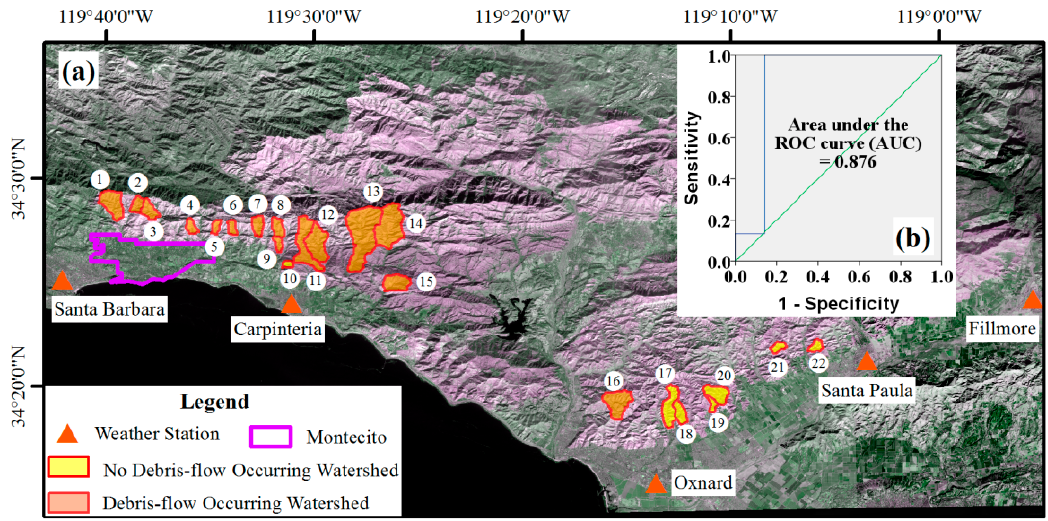
Figure 11. Model accuracy verification. ( a ) Watersheds used to be verified; ( b ) Receiver operating characteristic (ROC) curve and area under the curve (AUC) value.